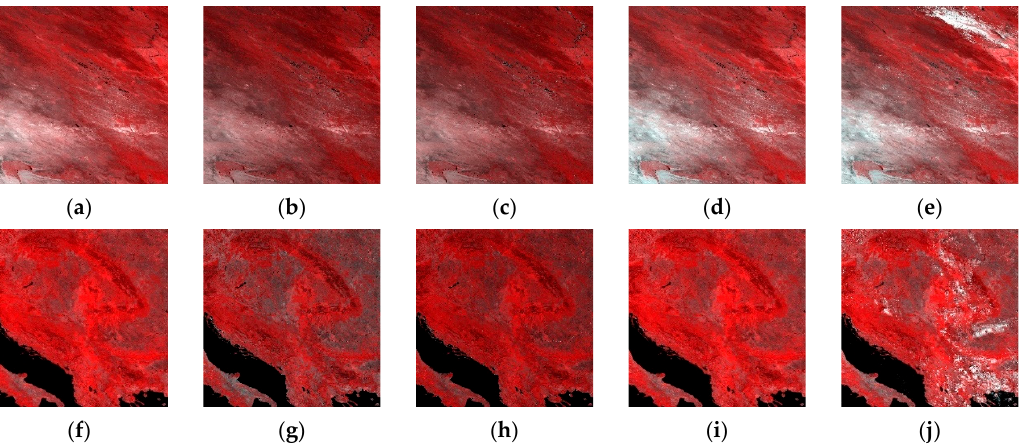
Figure 7. RGB images of the downscaled surface reflectance by ( a ) the DRCNN, ( b ) the bicubic interpolation method, ( c ) the ESPCN method, ( d ) the surface reflectance from the preprocessed MOD09Q1 product and ( e ) the surface reflectance from the MOD09Q1 product on day 265, 2015 at h26v04; ( f – j ) are the corresponding RGB images at h19v04. The RGB images were produced with an RGB color scheme that employs the NIR band (as red color), red band (as green color) and red band (as blue color).